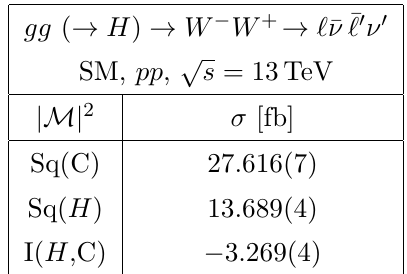
Table 8 . Partial decay widths for h in tables 1 and 2.